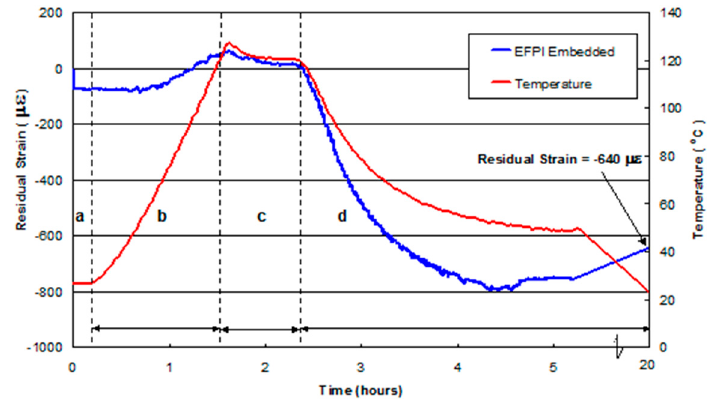
Figure 17. Strain measured using an embedded EFPI sensor in a reference [0] 16 laminate (manufactured without any pre-stress) during autoclave processing. The coded regions ( a – d ) represent the follows: ( a ) before curing; ( b ) heating cycle; ( c ) dwell period; and ( d ) cooling cycle.